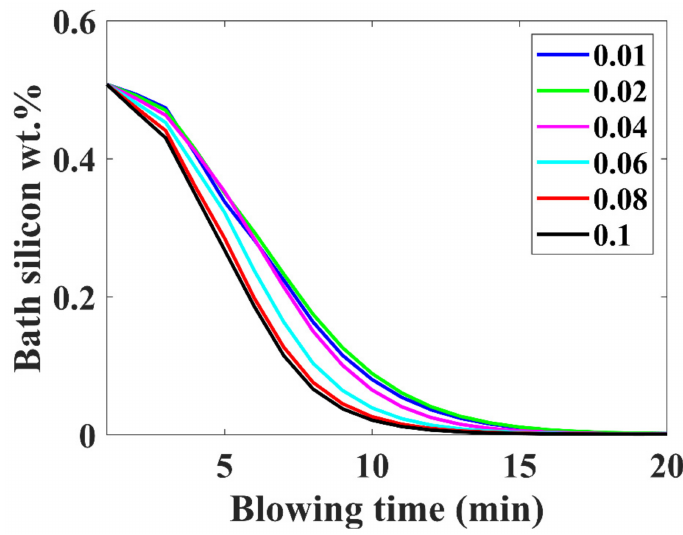
Figure 7. Variation in silicon wt % with blowing time at different inialpha values of 0.01 (blue), 0.02 (green), 0.04 (magenta), 0.06 (cyan), 0.08 (red), and 0.1 (black).